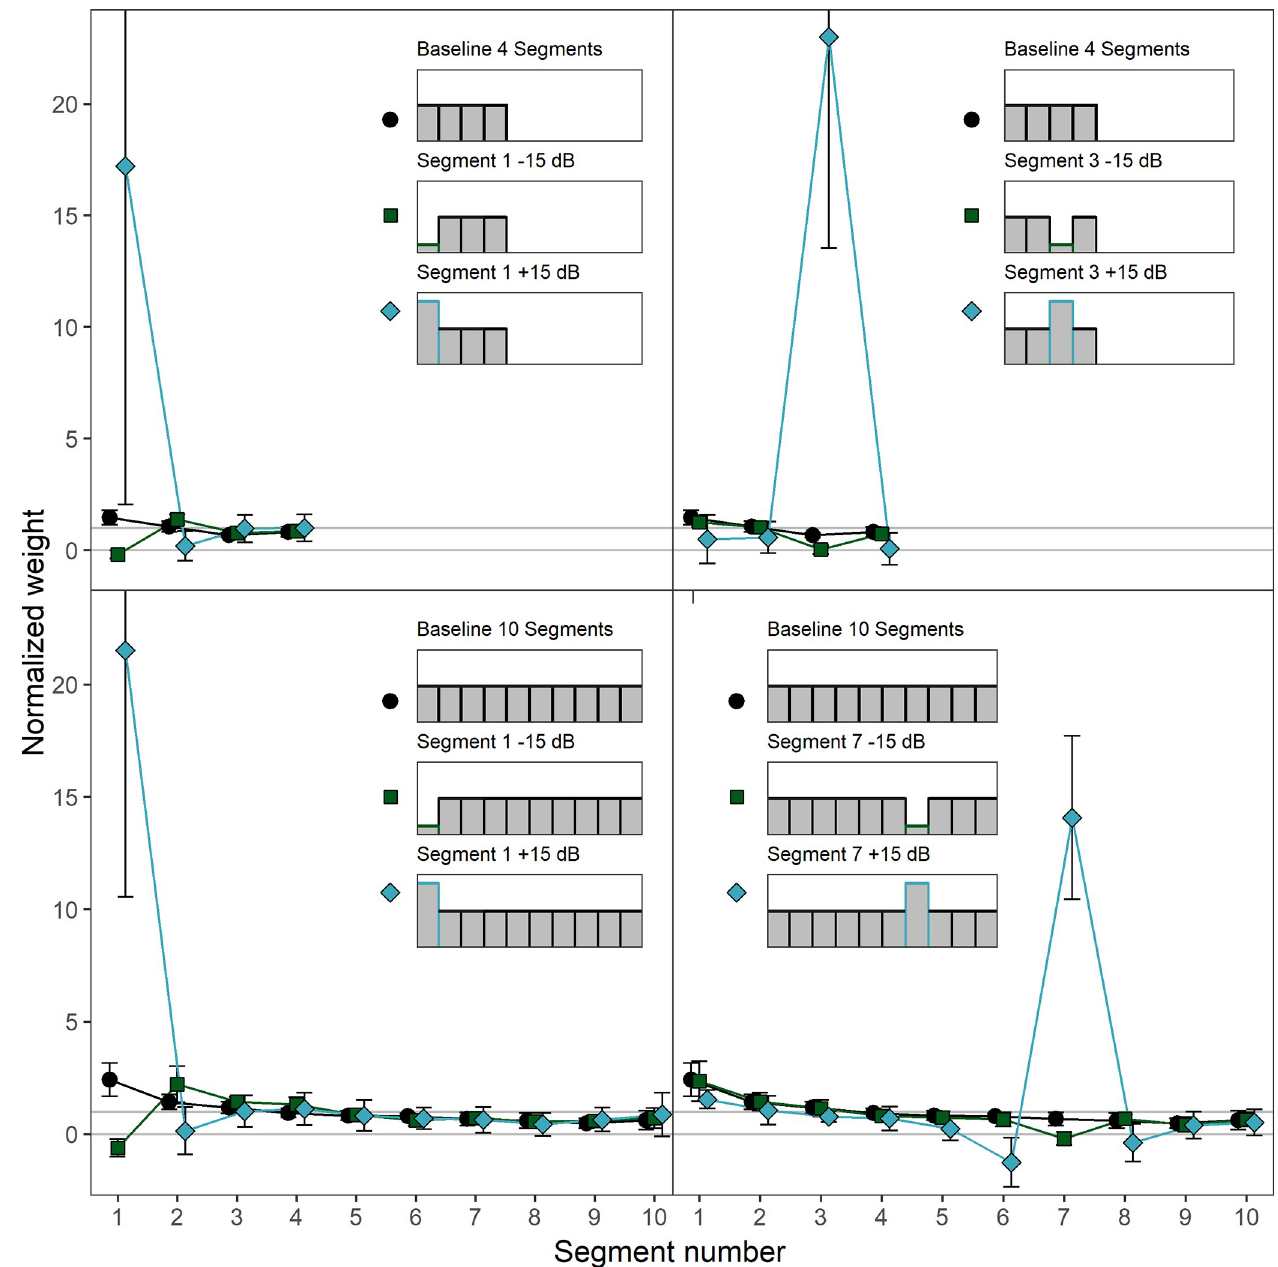
Fig 4. Experiment 2. Mean normalized weights as a function of segment number for the four- and ten-segment sounds. Upper panels: Four-segment sounds. Lower panels: Ten-segment sounds. Left panels: Attenuation/amplification of segment 1. Right panels: Attenuation/amplification of segment 3 (four-segment sounds) or 7 (ten-segment sounds). In each panel, depictions of the mean level profiles of the corresponding stimuli are shown in the upper half. The weights observed in the respective baseline condition in which none of the segments were attenuated or amplified are plotted in all panels of the figure for reference. Black circles: Baseline. Dark green squares: Attenuation by 15 dB. Blue-gray diamonds: Amplification by 15 dB. Error bars show 95% confidence intervals (CIs). Note that for better visibility, the lines are shifted slightly against each other on the x-axis.